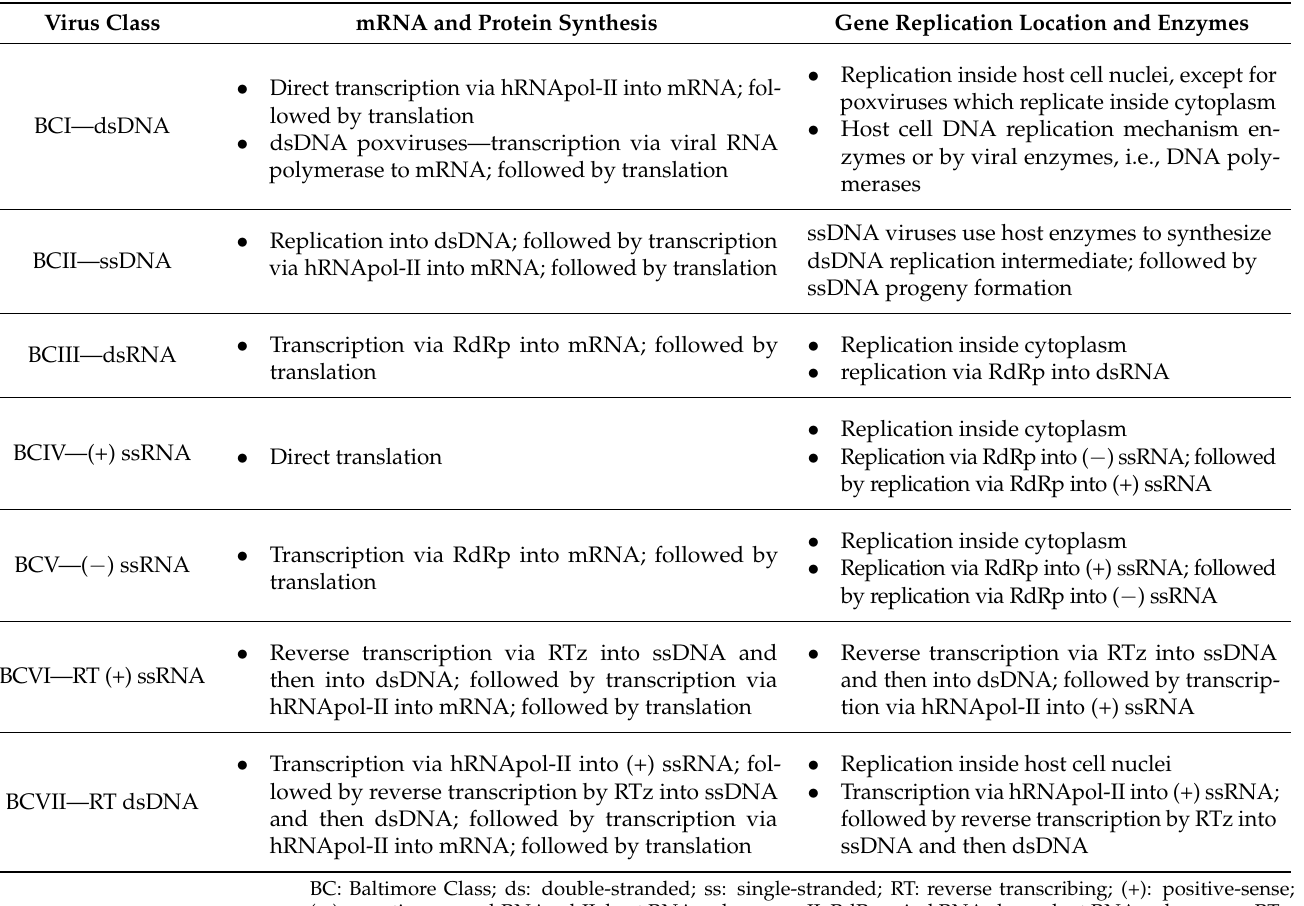
Table 2. A stepwise summary of gene expression and gene replication mechanisms among different classes of viruses